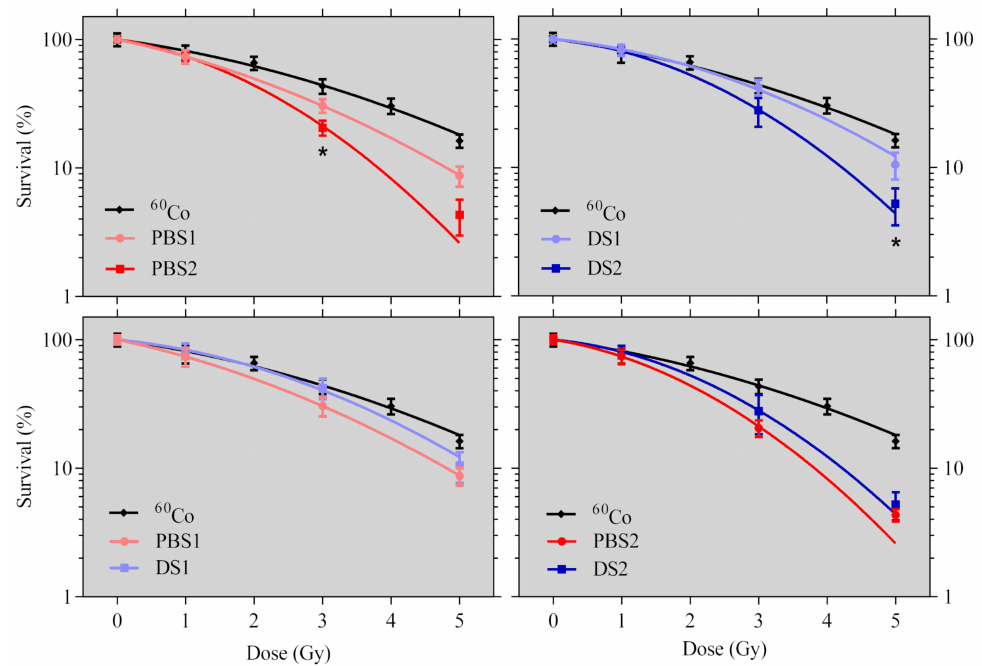
Figure 2. Clonogenic cell survival data of cells irradiated by Pencil Beam Scanning (PBS) and Double Scattering (DS) proton modes in the two irradiation positions (1—plateau, 2—Bragg peak) and by a 60 Co gamma source. Up: a comparison of the two positions for each of the modes. Down: a comparison of the two modes for each of the positions. Points correspond to the experimental averages, with their standard deviations and lines corresponding to the LQ model fit. The asterisk (*) corresponds to t -tests lower than